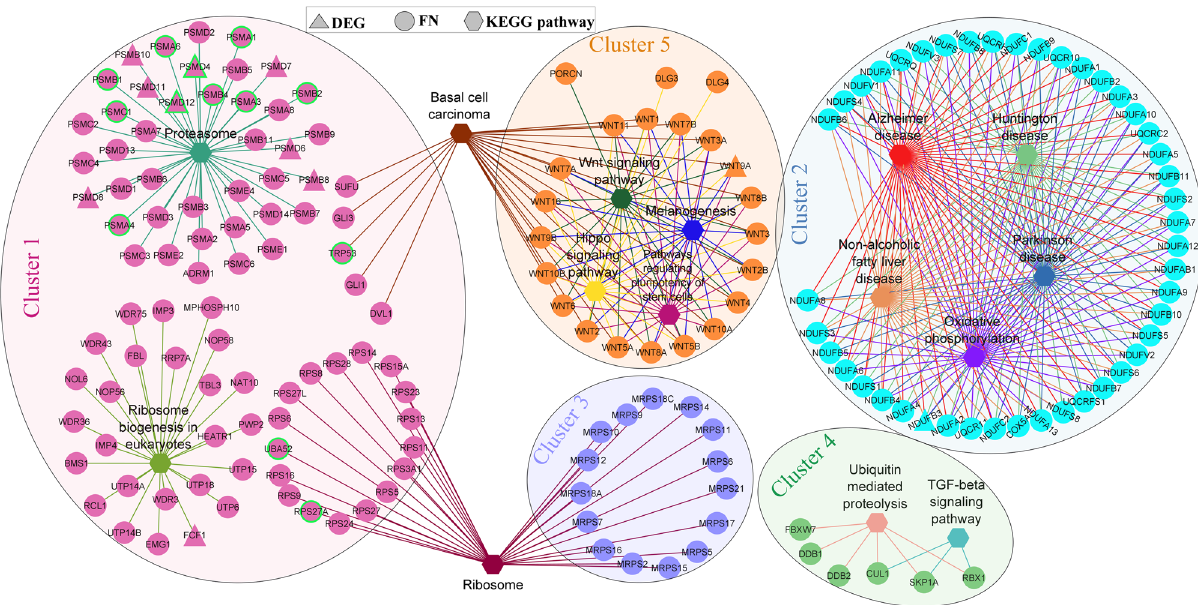
Figure 4. Top five MCODE clusters of the ageing network obtained using the DEGs between 3 and 27 month old mice and their first neighbours. Pathway enrichment of clusters are shown along with the gene information. Hub nodes/genes are highlighted with green border.